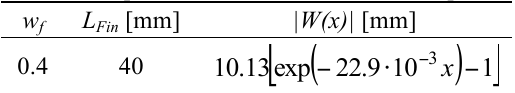
Table 1: Optimized values of the fin line tapers.